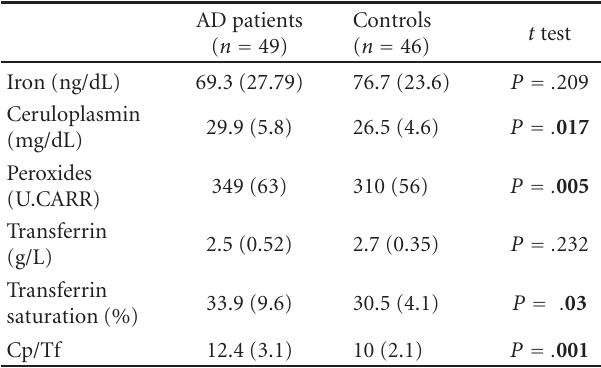
Table 2: Serum levels of the investigated variables in AD patients and controls (means